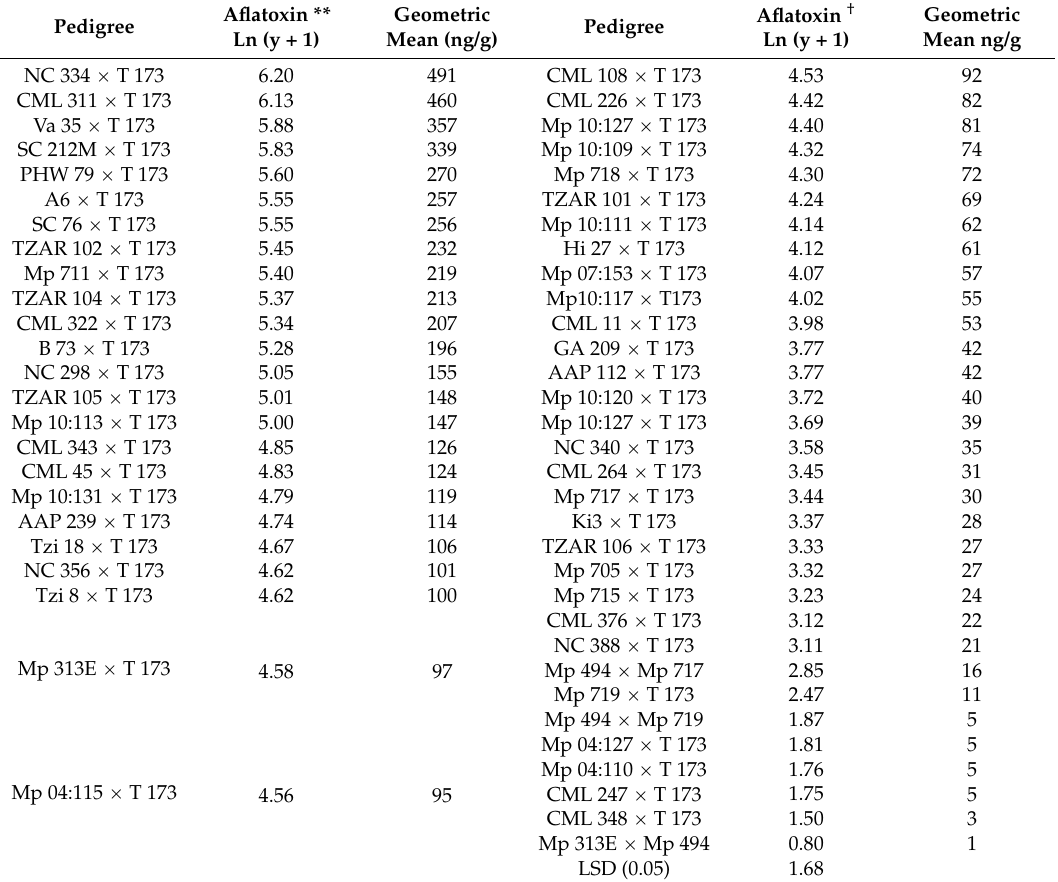
† Plot means for aflatoxin concentration were transformed (Ln (y + 1), where y = concentration of aflatoxin in a sample) before statistical analysis. Geometric means were calculated by reverse transformation of logarithmic means back to the original units of